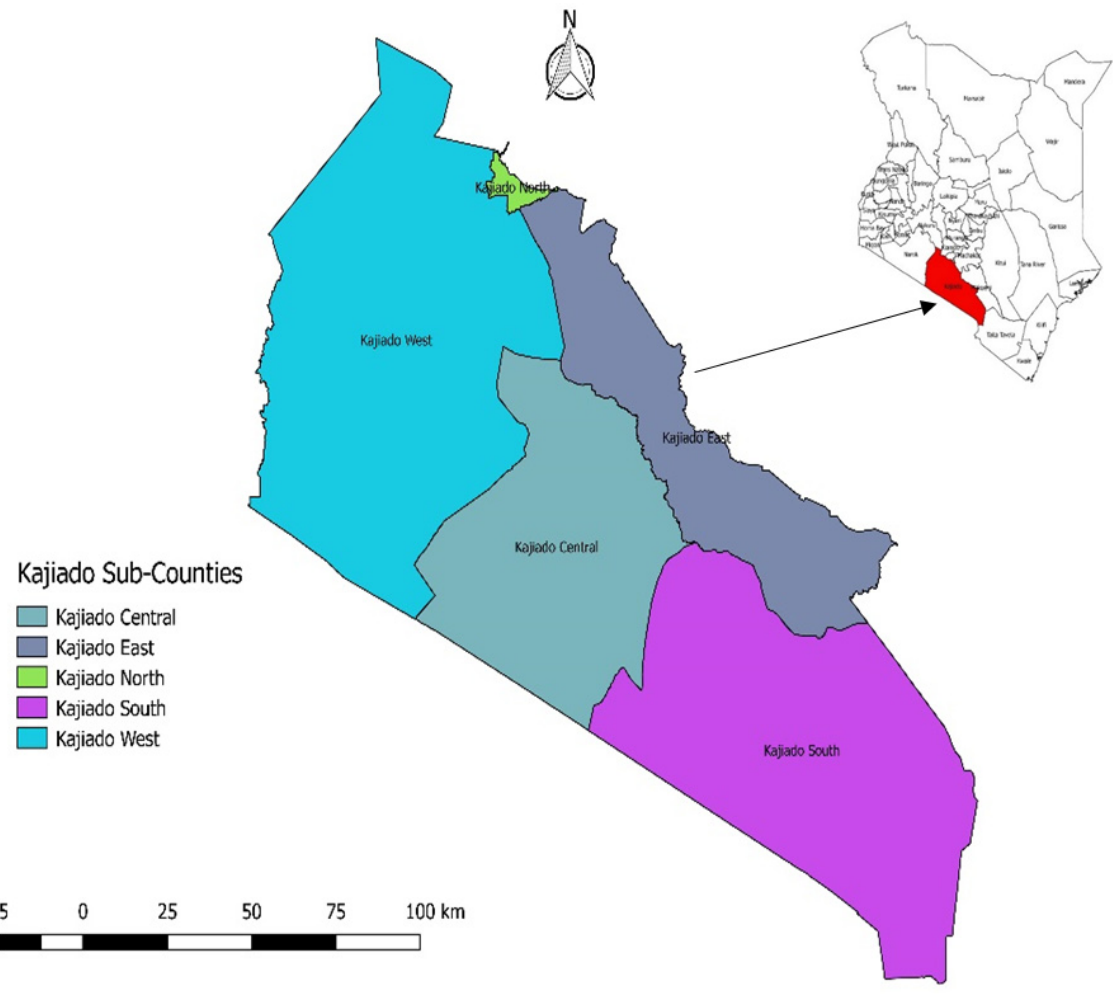
Figure 1. Map of Kenya showing administrative regions in Kajiado